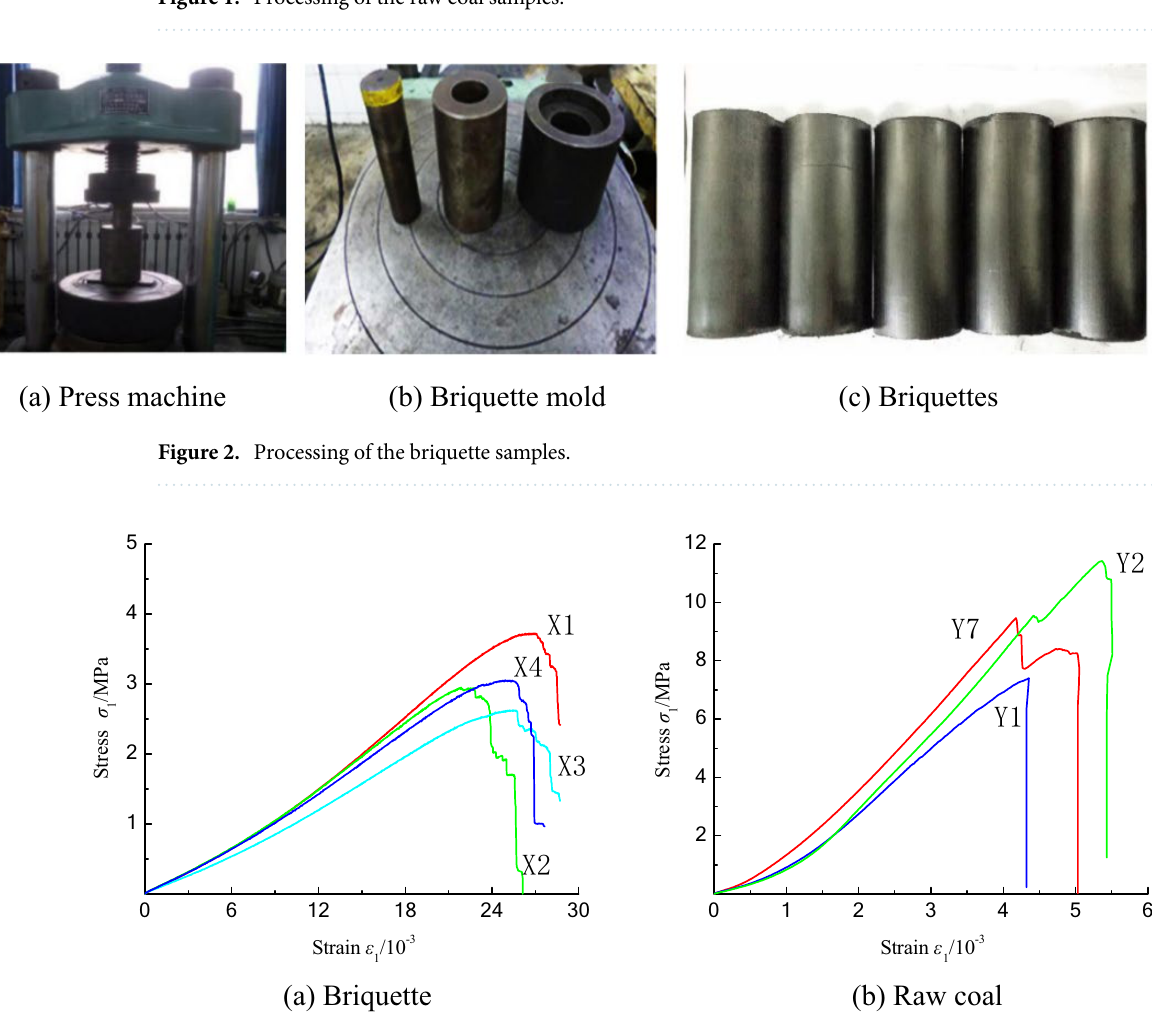
Figure 1. Processing of the raw coal samples.